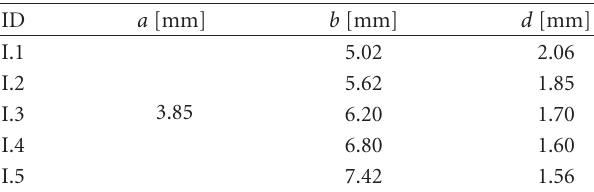
Table 1: First set of DRA dimensions ( a , b , d ) considered for a rectangular DRA operating in the fundamental TE z 14 . 25 GHz.